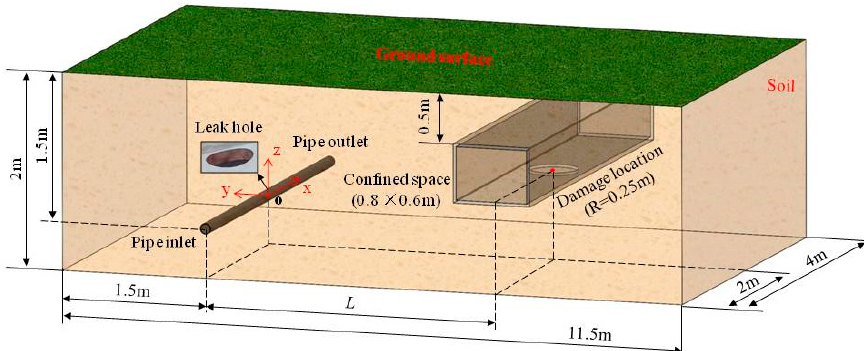
Figure 1. Schematic diagram of the physical model.